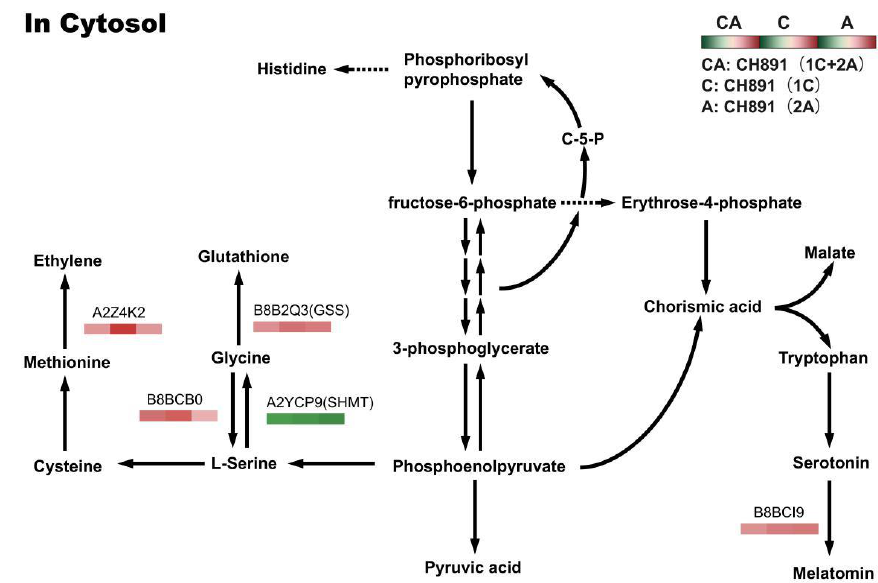
Figure 11. Changes in quantified proteins associated with the glycine, serine, and threonine metabolism pathways in three transgenic lines (NIL groups) and control lines (left box: CH891(1C+2A)/CH891, center box: CH891(1C)/CH891, right box: CH891(2A)/CH891).